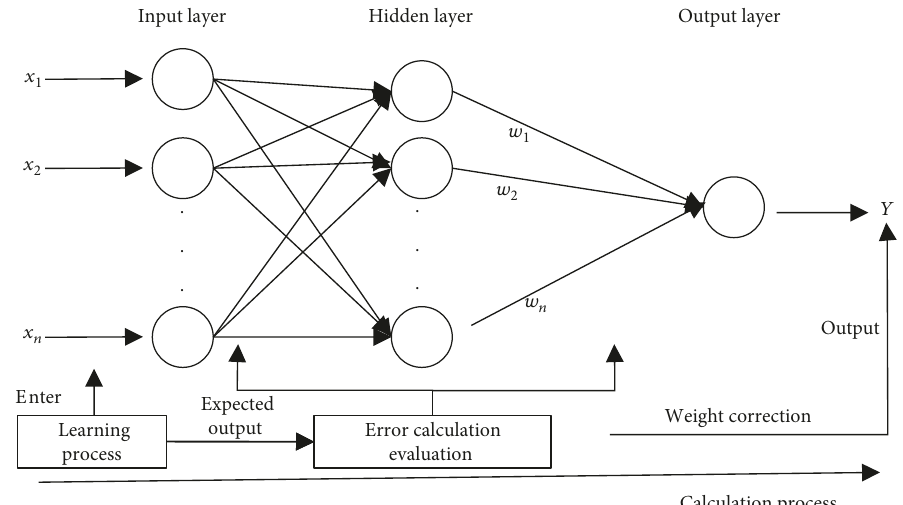
Figure 6: Structure of credit tracking model based on BP neural